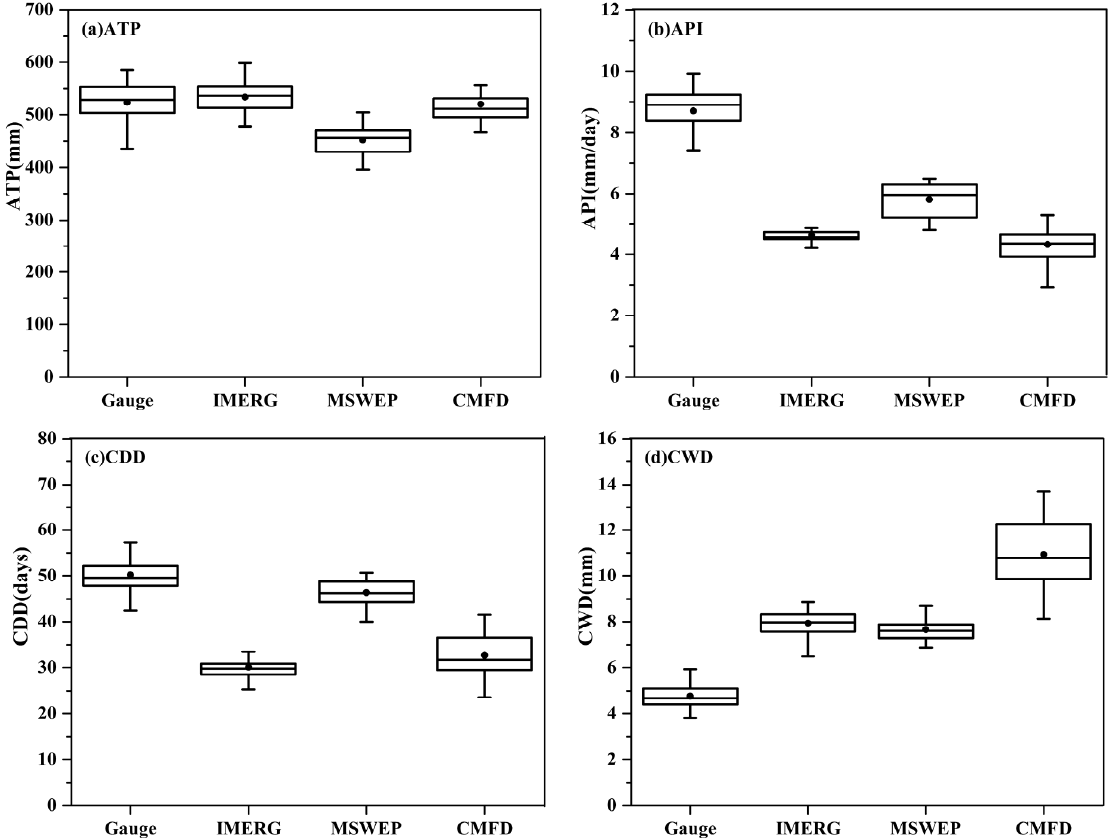
Figure 3. Boxplots for the four total indices and the persistent indices: ( a ) ATP, ( b ) API, ( c ) CDD, and ( d ) CWD for the rainfall station data and the three satellite-derived precipitation data products at 36 stations.